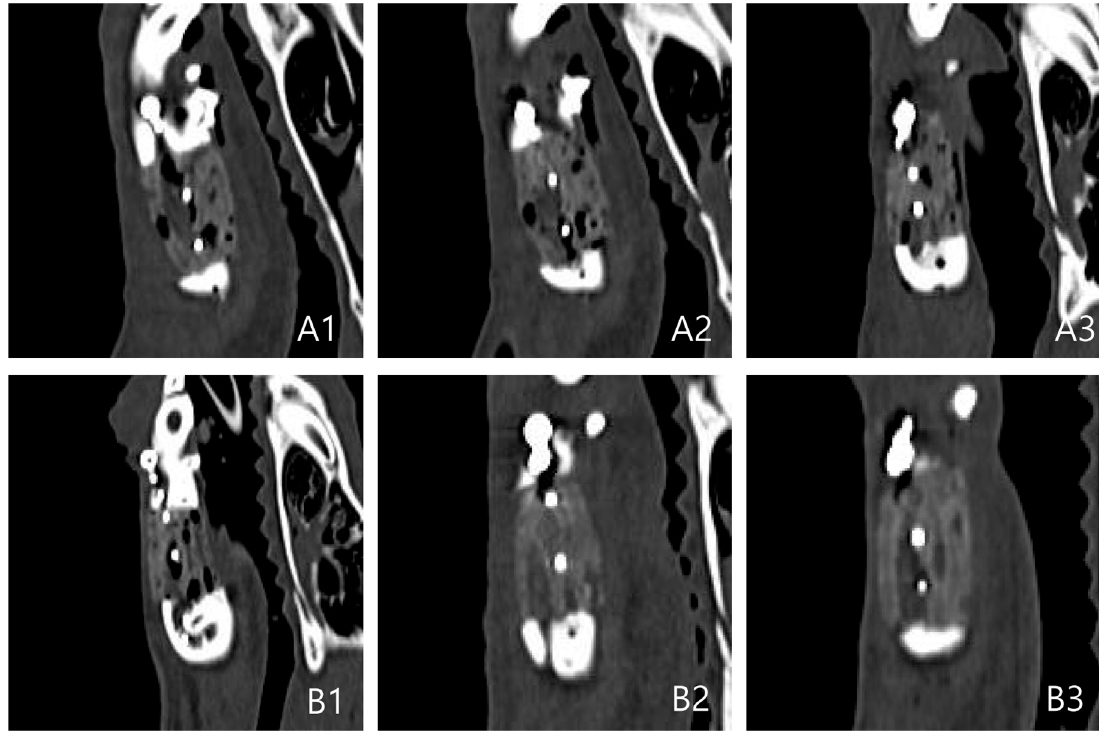
Figure 1. Sagittal views of CT. ( A ) PTE group. ( B ) PTE + SA group (1. immediate postoperative findings, 2. postoperative 4 weeks findings, 3. postoperative 8 weeks) .